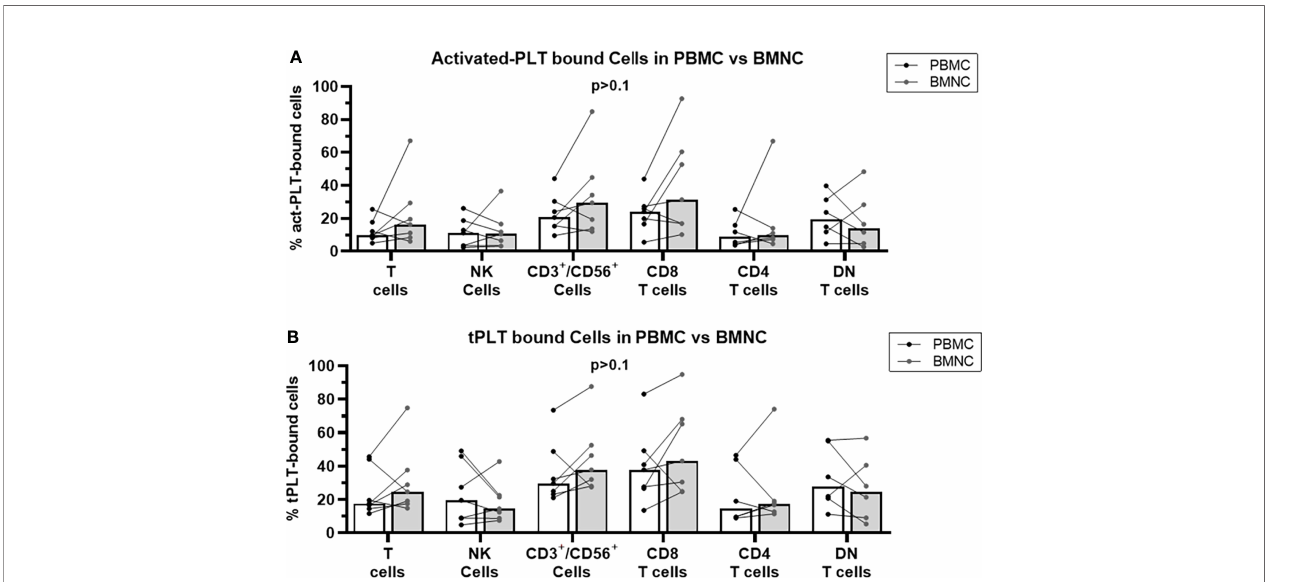
FIGURE 3 | BMNC and PBMC show comparable frequencies of PLT-bound cells in MPN patients. PBMC (black dots and empty bars) and BMNC (grey dots and grey fi lled bars) were isolated from seven JAK2- mutated MPN patients (ET = 1; PV = 5; PMF = 1). (A) activated-PLT (act-PLT) bound lymphocytes and (B) total (tPLT)- bound lymphocytes were evaluated using fl ow cytometry (Panel II, Supplemental Table 1 ). The graph shows the frequencies of act-PLT-bound cells for different lymphocytic populations and all frequencies are shown as percentage of parent population. The bars represent the median frequency for each population. Multiple unpaired T tests were used to compared PLT bound cells in PBMC and BMNC samples, and differences were considered signi fi cant when p <